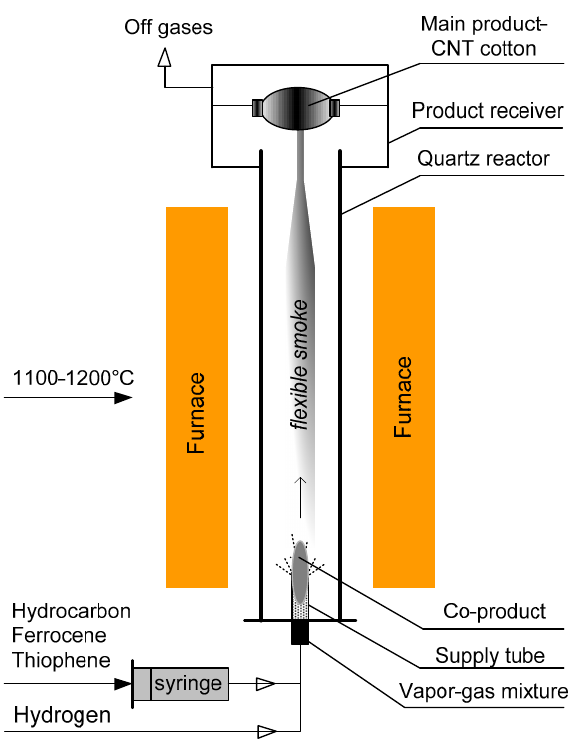
Figure 1. Schematic representation of the proprietary float ‐ catalysis synthesis reactor rig.